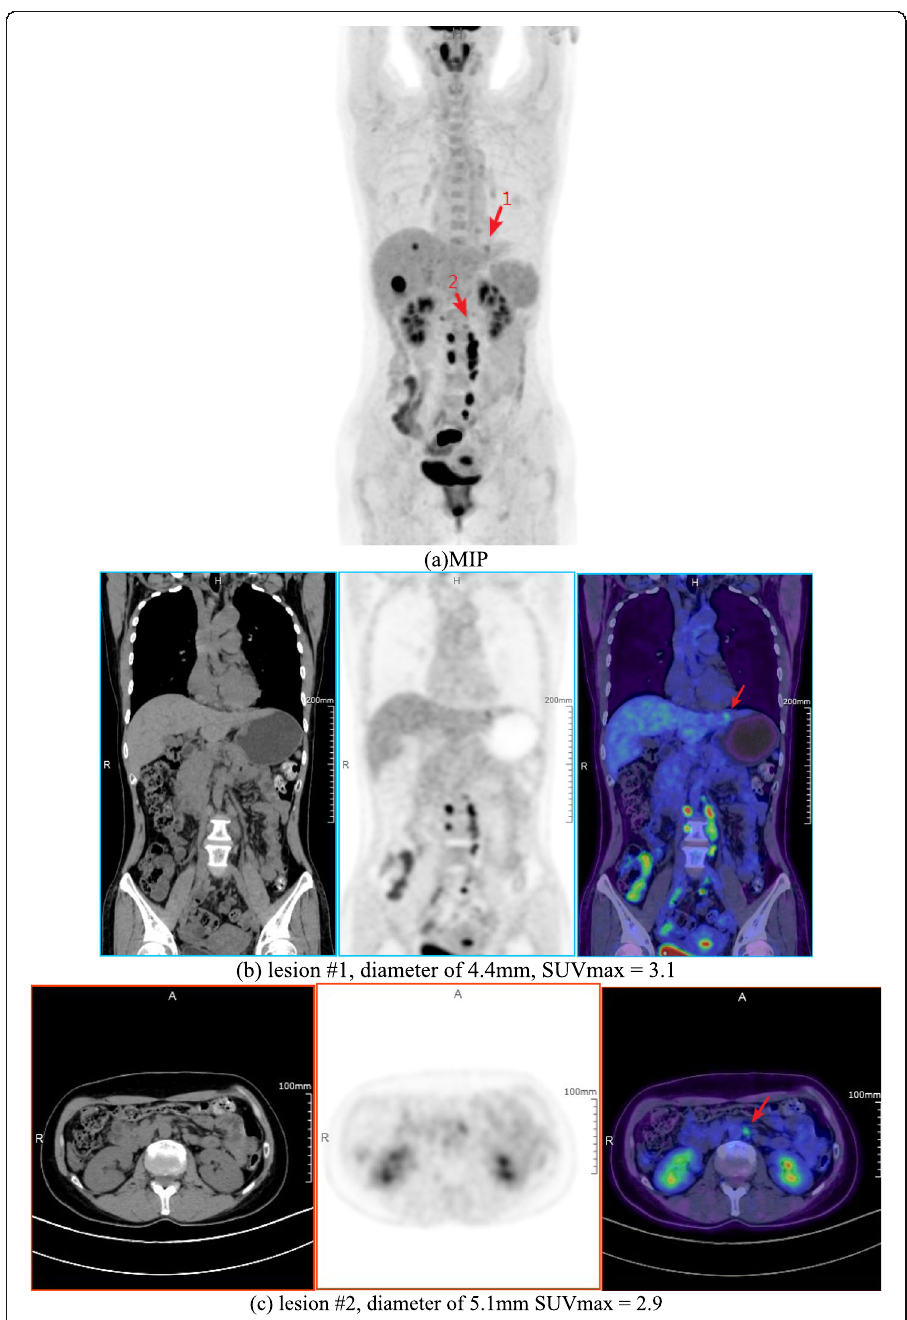
Fig. 6 Second patient images. a MIP, two small lesions were pointed out by red arrows. b Lesion #1 images, from left to right, CT, PET, and PET/CT fusion image. c Lesion #2 images, from left to right, CT, PET, and PET/CT fusion